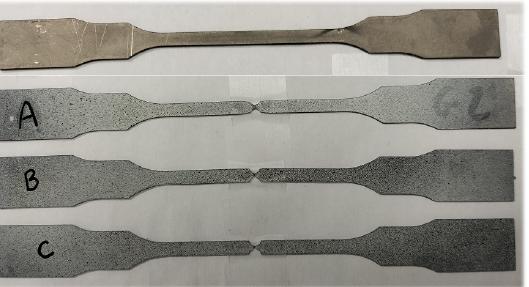
Figure 4. Notched (A: R = 0.5 mm; B: R = 1 mm; C: R = 1.5 mm) and un-notched specimens used in tensile